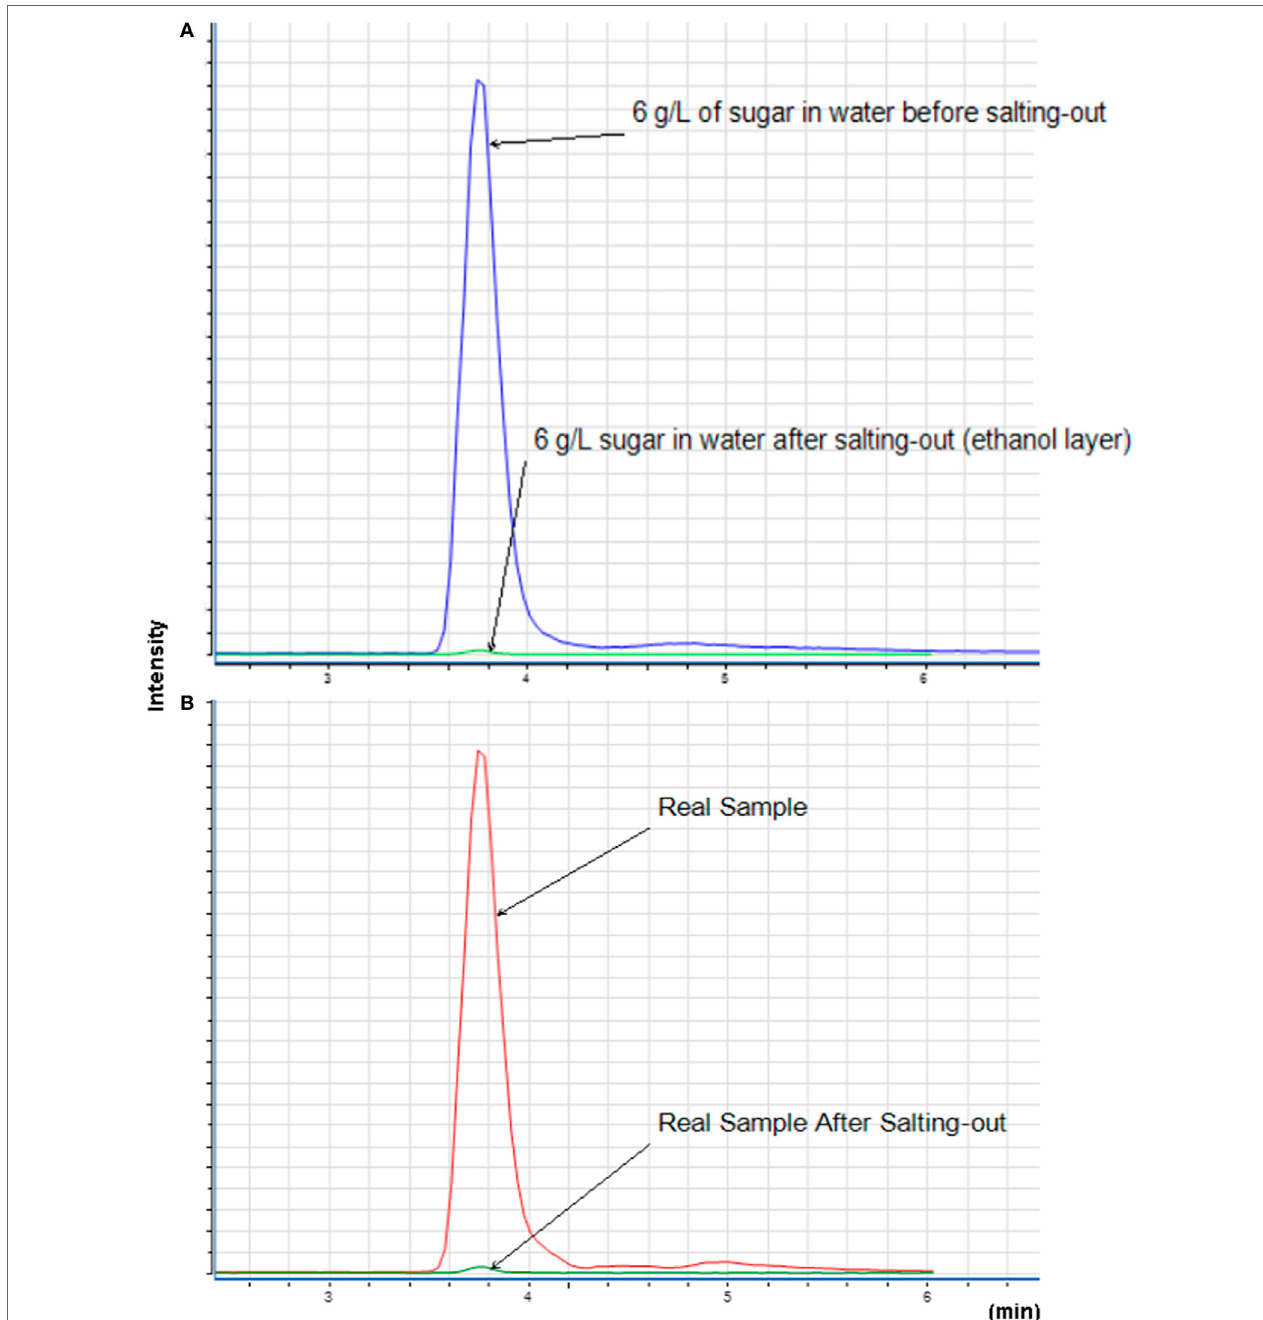
FigUre 4 | Extracted ion chromatogram of 6 g L − 1 of sugar (a) and with a sample of cachaça (B) before and after QuEChERS extraction, injecting only the organic layer for both